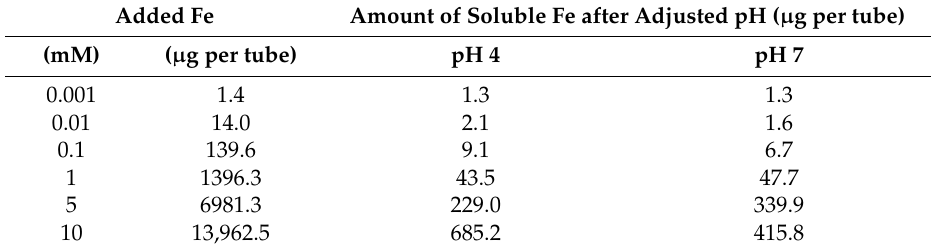
Table 3. Soluble Fe in solution (no biochar present) at different concentrations after adjustment to pH 4 and pH 7. Added Fe